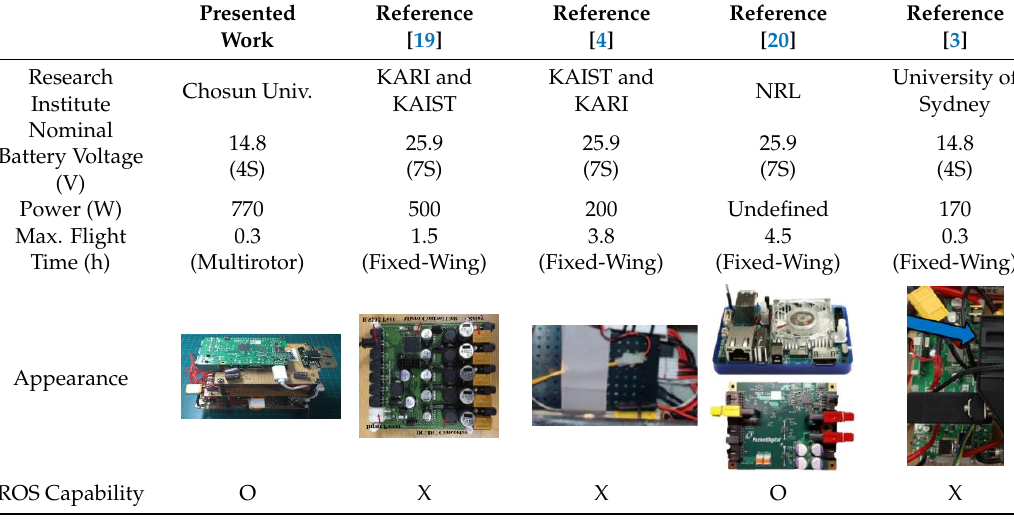
Table 6. Comparison of the HPC boards managing PV, a fuel cell, and a battery pack.